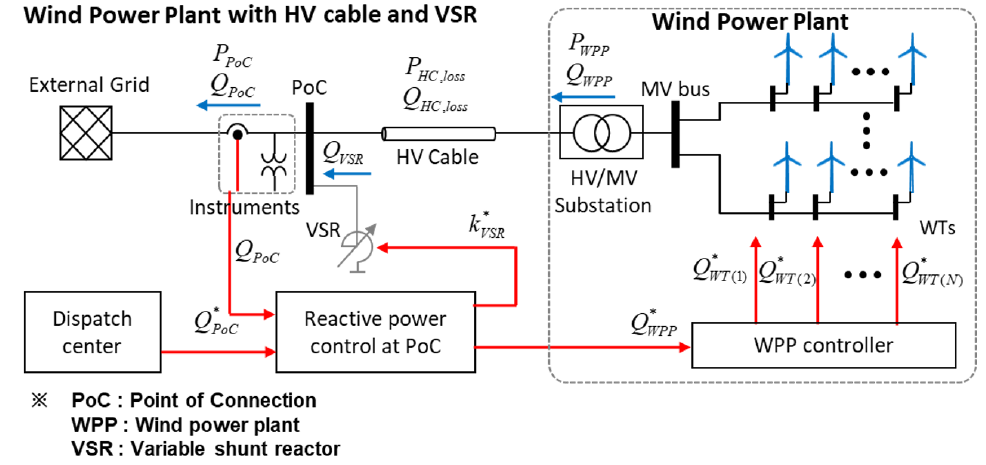
Figure 2. Configuration and reactive power control of wind power plant with HV cable and VSR.